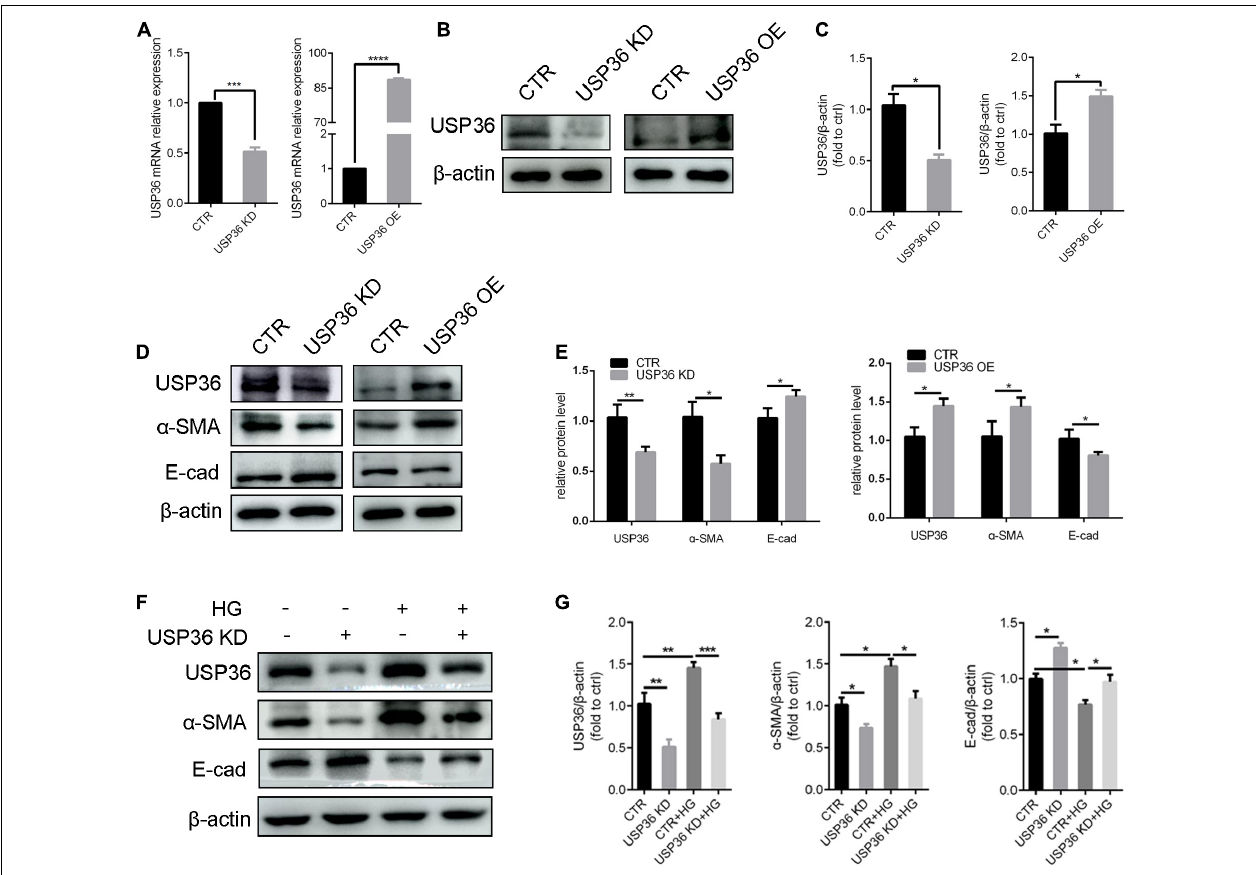
FIGURE 3 | USP36 participates in the regulation of hyperglycemia-induced EMT in TECs. (A) RT-qPCR showed knockdown or overexpression efficiency of USP36 in TECs. Unpaired, two-tailed t tests were used, n = 3, *** p < 0.001, **** p < 0.0001. (B,C) WB analysis of the protein levels of USP36 after transfected with USP36-silencing siRNA or USP36-overexpressing plasmids. Data are presented as the mean ± S.D, n = 3, * p < 0.05. (D,E) WB analysis of the protein levels of USP36, α -SMA and E-cad after knockdown or overexpression of USP36. Data are presented as the mean ± S.D. n = 3, * p < 0.05, ** p < 0.01. (F,G) WB analysis